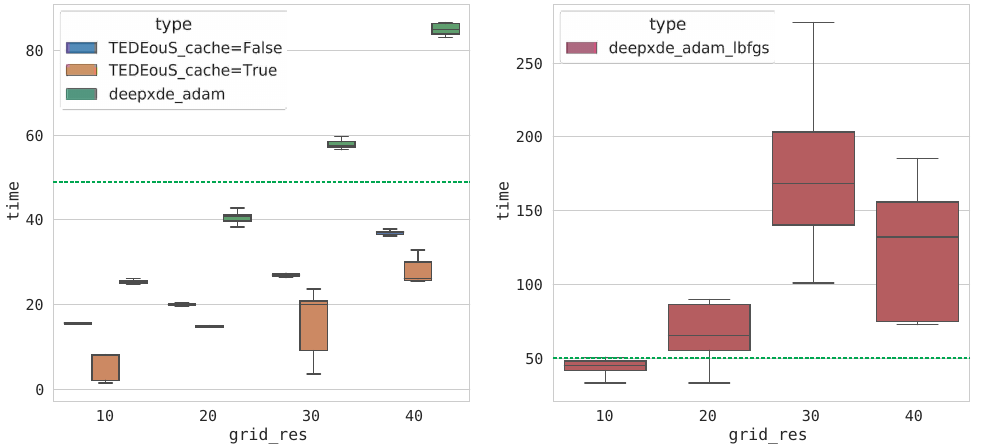
Figure 13. Optimization times for different methods: orange—proposed approach without cache, blue—with cache, green—DeepXDE without additional LBFGS refinement, red—with LBFGS